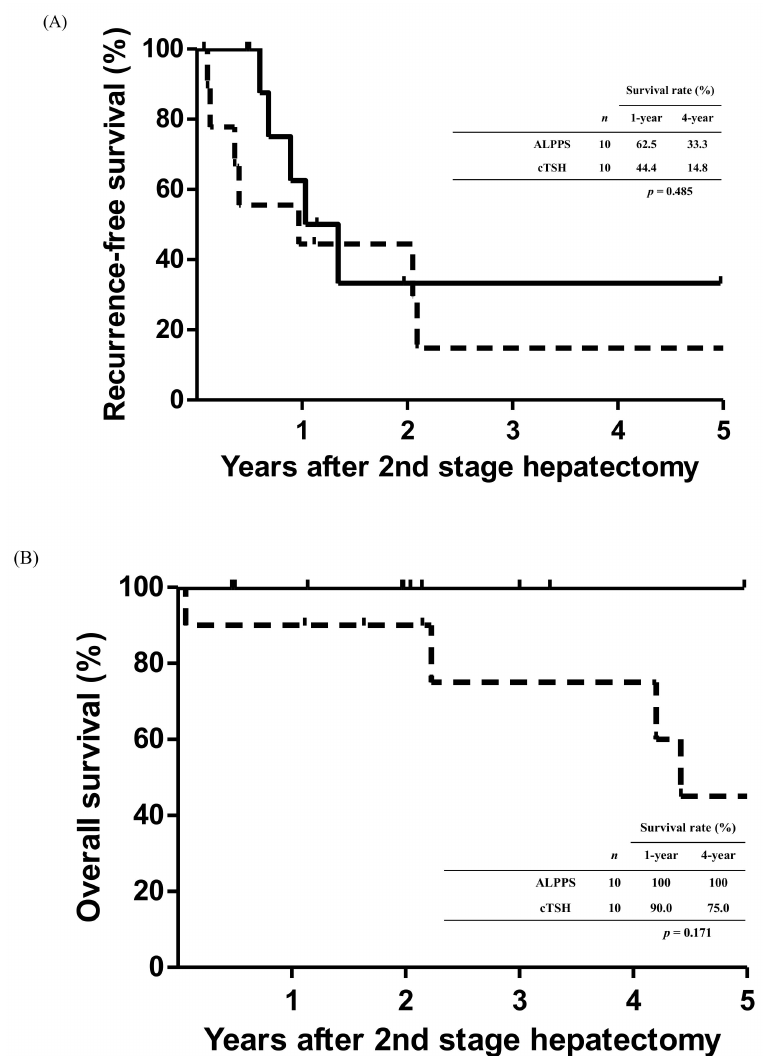
Figure 5. Kaplan–Meier survival curves in patients undergoing staged hepatectomy after propensity score matching. ( A ) The comparison of recurrence-free survival between the two groups had no significant difference. ( p = 0.485). ( B ) The overall survival curves were also no significant difference between the two groups. ( p =